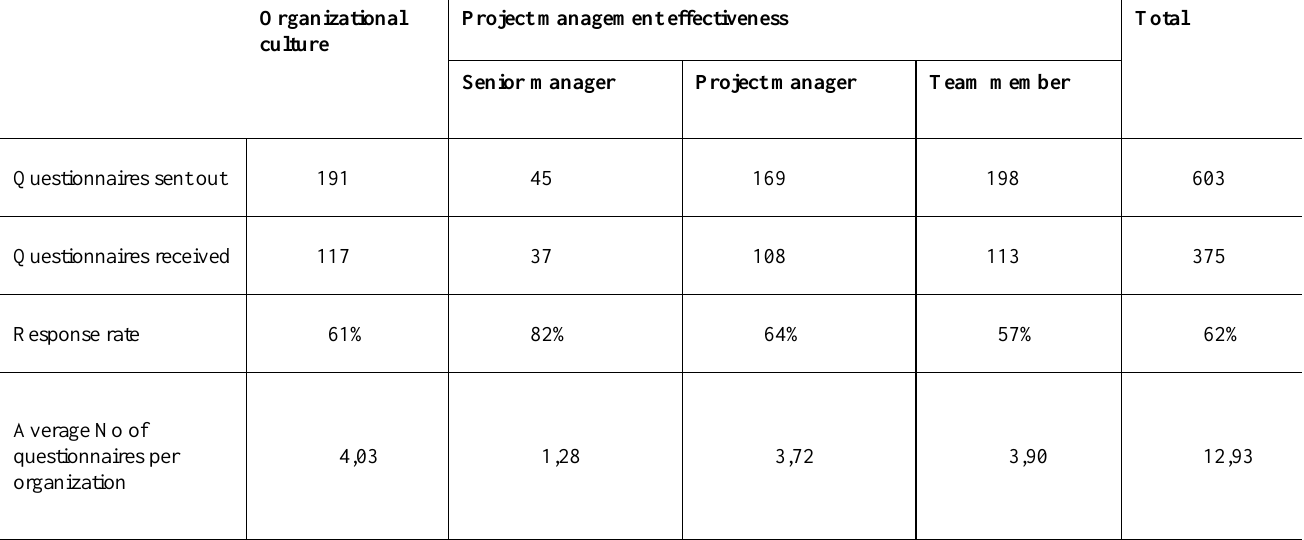
Table 3: Survey response analysis